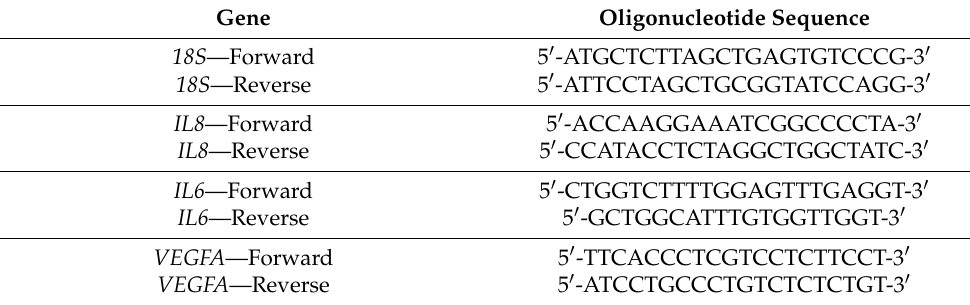
Table 2. Primers used in this work in mRPE